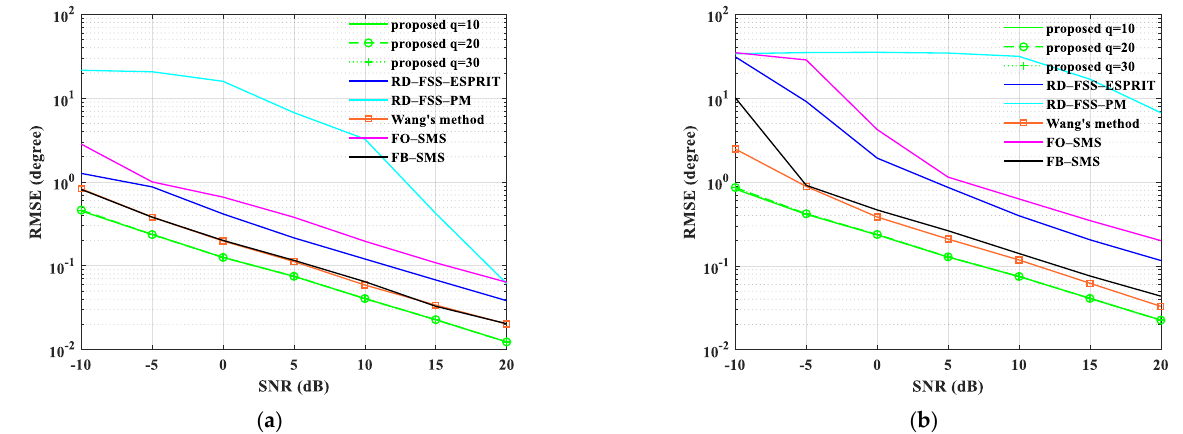
Figure 5. RMSE versus SNR. ( a ) Scenario 1: three coherent targets are located at 5 ,10 ,15  = . ( b ) Scenario 2: θ k = 45 ◦ ,50 ◦ ,60 ◦ ( b ) Scenario 2: 45 ,50 ,60 k